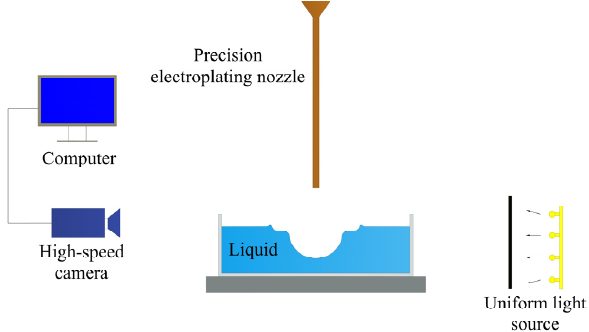
Figure 8. Schematic diagram of the measuring device.